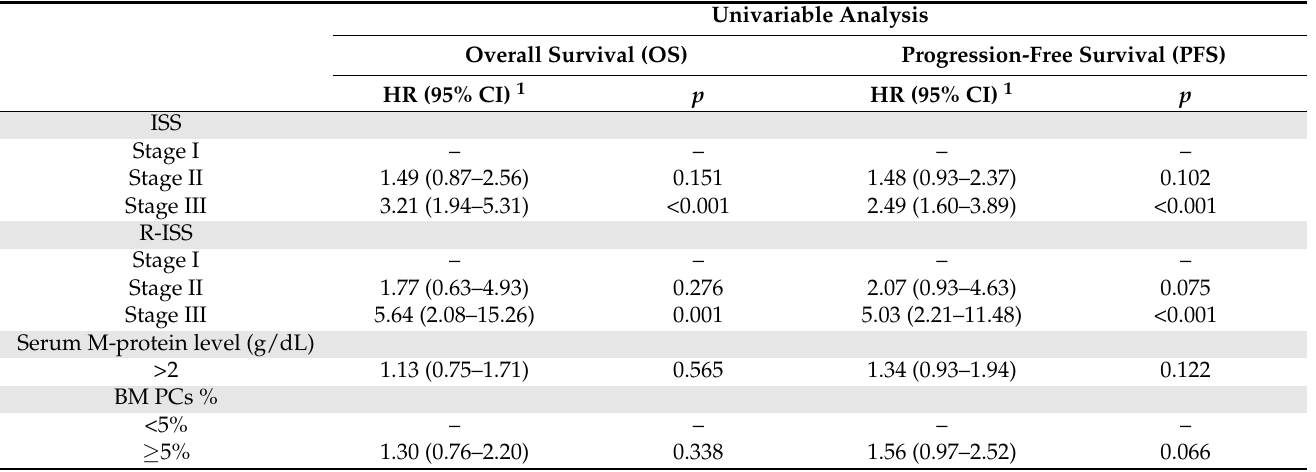
Table 2. Association of clinical features with OS and PFS in NDMM patients with EMD plasmacytomas. Univariable